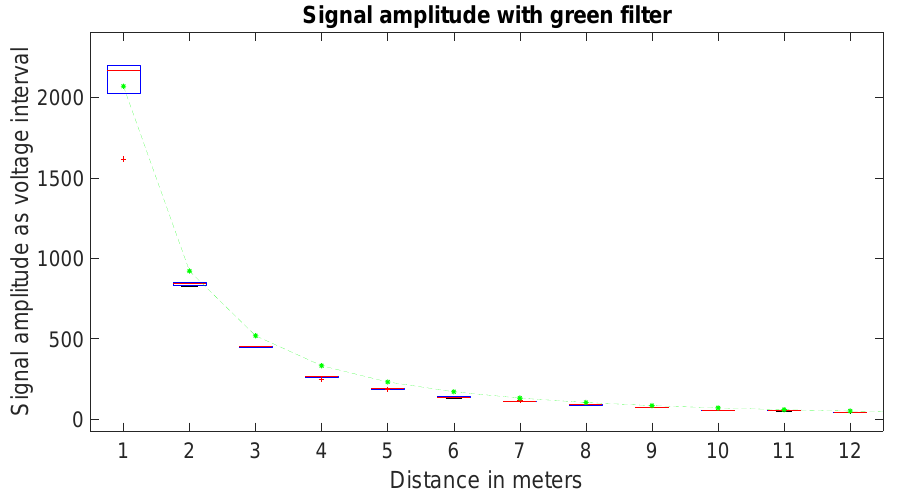
Figure 12. Box plot of attenuation of the signal with respect to distance using the green